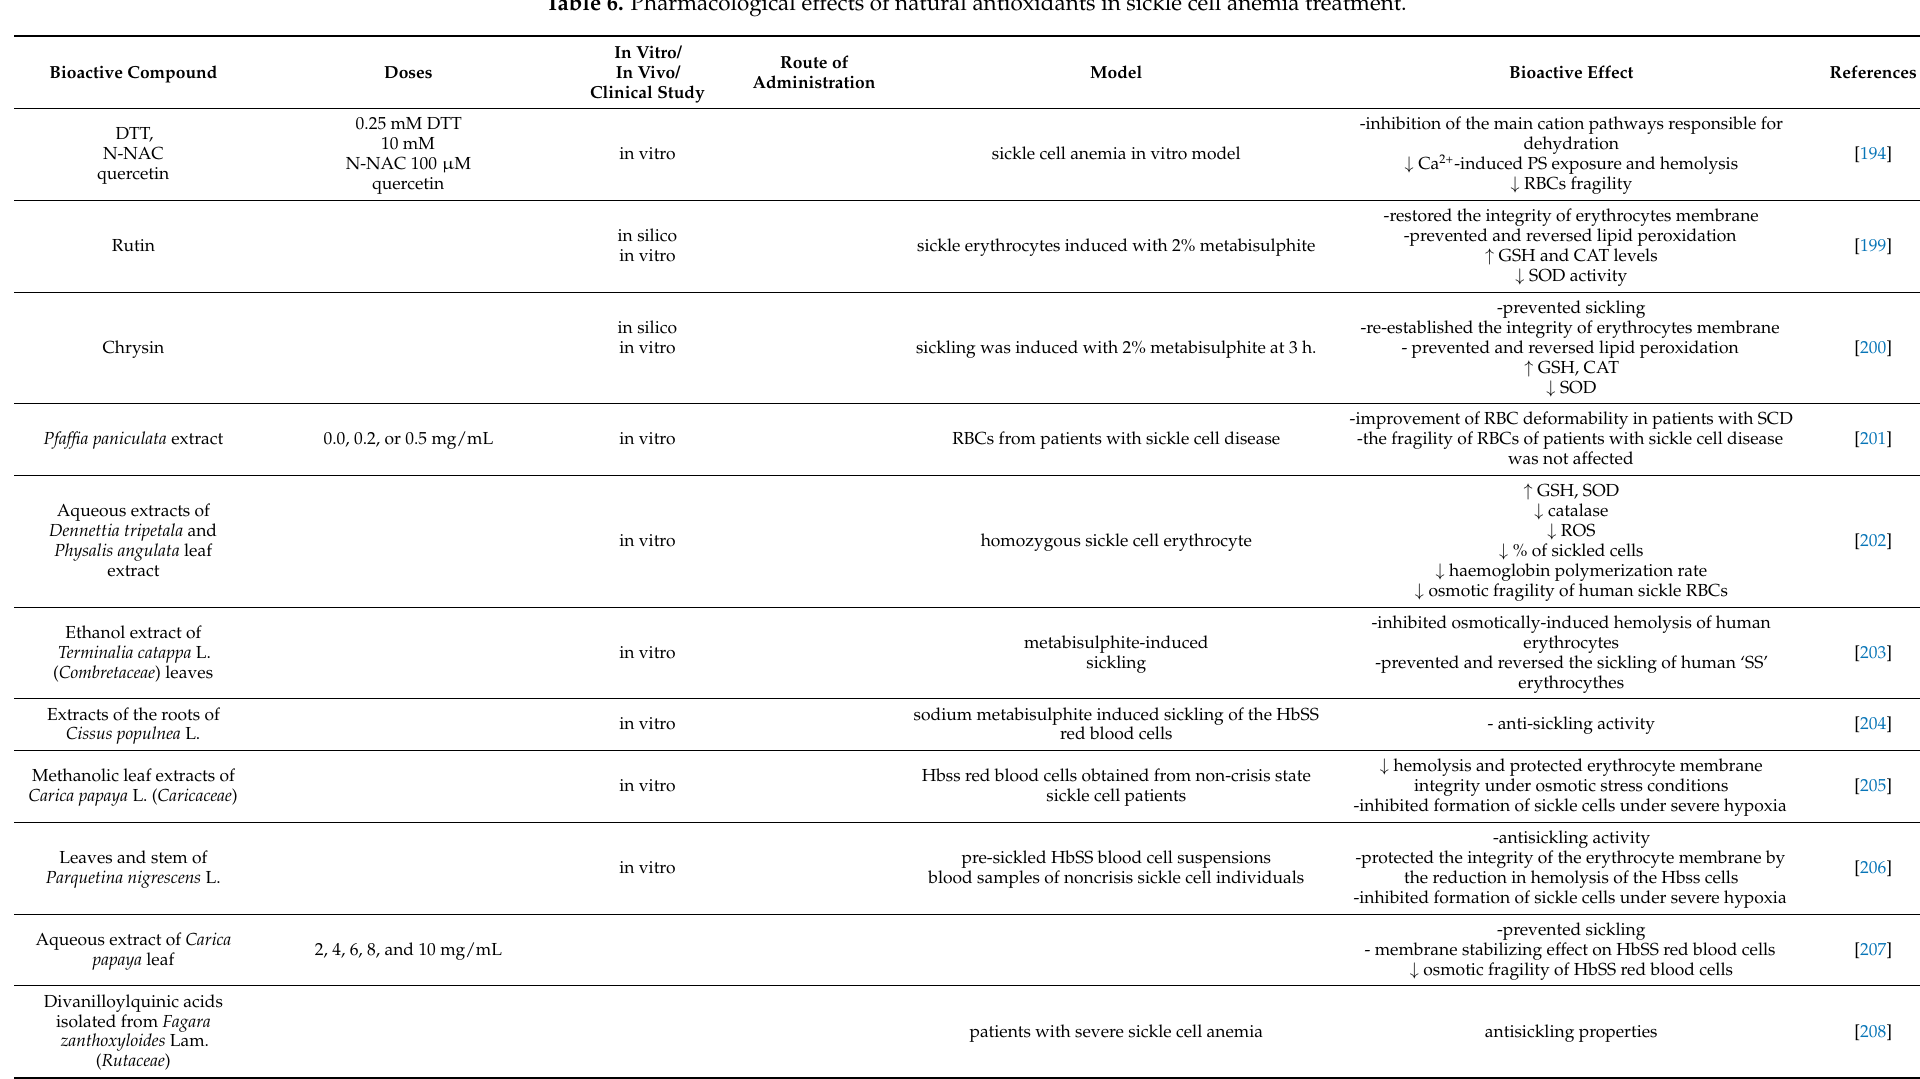
Table 6. Pharmacological effects of natural antioxidants in sickle cell anemia